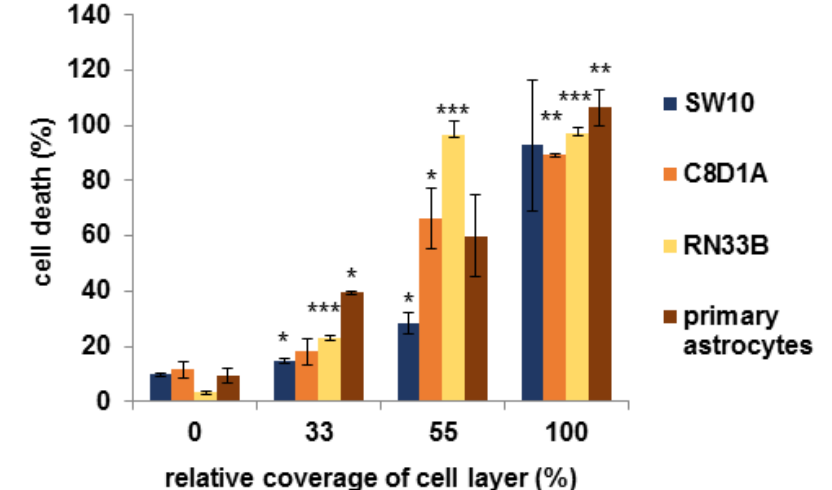
Figure 5. Tabotamp ® -dependent cell death of Schwann cells, neuronal cells and astrocytes. 5 × 10 3 Schwann cells (SW10), respectively, 1 × 10 4 astrocytes (C8D1A; primary astrocytes) or neuronal cells (RN33B) were seeded in triplicates in black flat 96 well plates and incubated for 24 h. Then, 0, 11, 19, and 34 mm 2 of Tabotamp ® (0, 33, 55, and 100% coverage of cell layer, respectively) and the fluorescence dye CellTox Green was added to the cells as described in manufacturer’s instructions. The fluorescence signal was measured after 30 min. Total cell lysis was set to 100% cell death. Cell free medium served as background control. The figure shows the means and standard deviations of three independent assays. Statistical analysis was performed with one-way ANOVA followed by Dunnett’s post hoc test. Significance was accepted if p -values were < 0.05 (* p < 0.05, ** p < 0.025, *** p < 0.001).